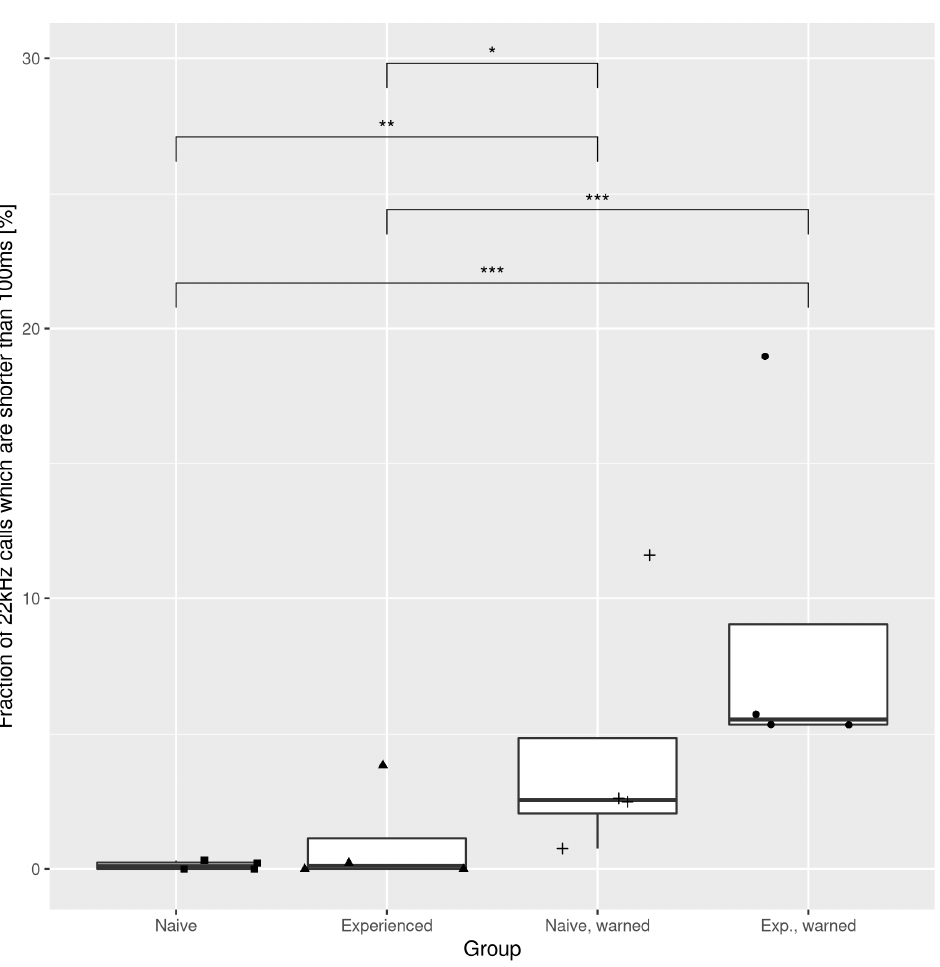
Figure 5. Fraction of short (<100 ms) 22 kHz calls in the different experimental groups. Brackets mark significant differences identified by the Conover–Iman test. * p < 0.05; ** p < 0.01; *** p < 0.001.